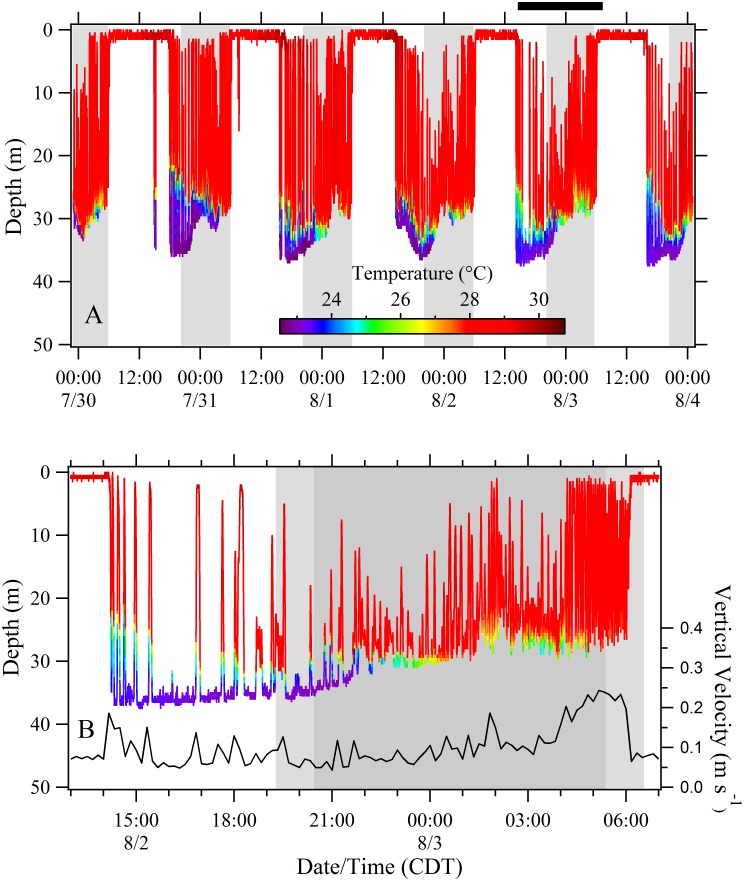
Depth-temperature profiles for Shark 33 tagged in the Afuera aggregation.(A) Five-day period post-tagging demonstrating a pattern of daytime surface swimming beginning near sunrise followed by regular vertical movements beginning in the mid afternoon. (B) An 18-hour period demonstrating dynamic vertical oscillations beginning in the afternoon and ending near sunrise (period corresponds to the black bar in A). High frequency bounce dives were observed during the 2-hr period prior to the resumption of surface swimming (04:00–06:00). The absolute vertical velocity increased to approximately 0.25 m s-1 during this period. The dark grey shading represents nighttime while the lighter gray represents twilight.